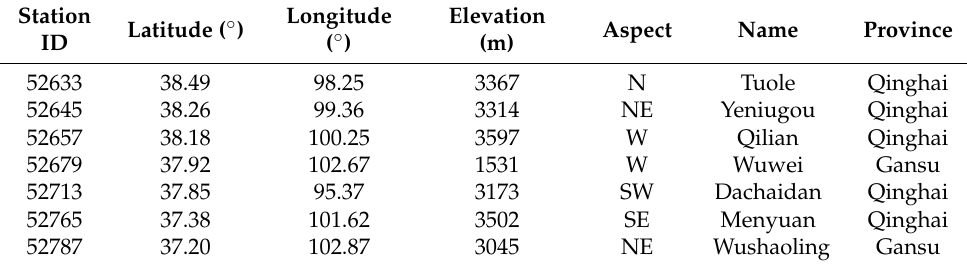
Table 2. Details of the meteorological stations near glacier areas in the Qilian